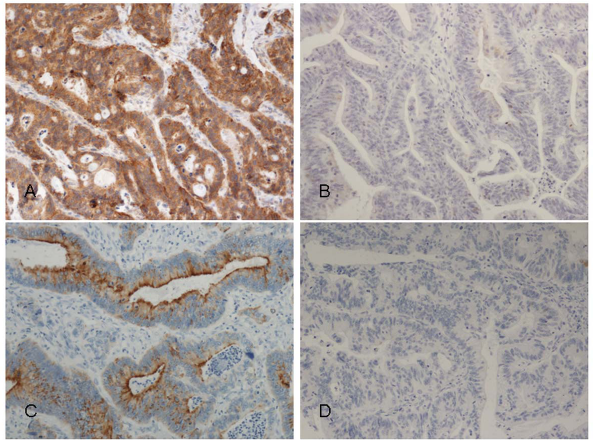
Figure 1. Immunohistochemical scoring pattern of EGFR and TATI/SPINK1 in colorectal cancer. A. EGFR positive, B.